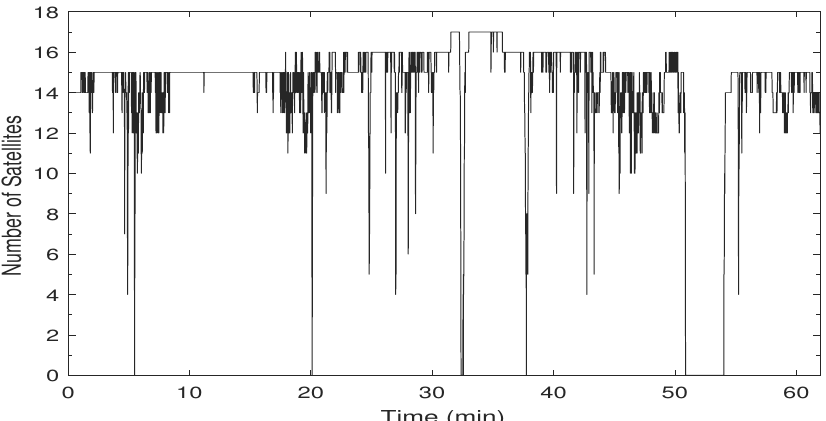
Figure 10. Number of satellites used in the PPP solution of the second trajectory of SF-PPP/INS integration.